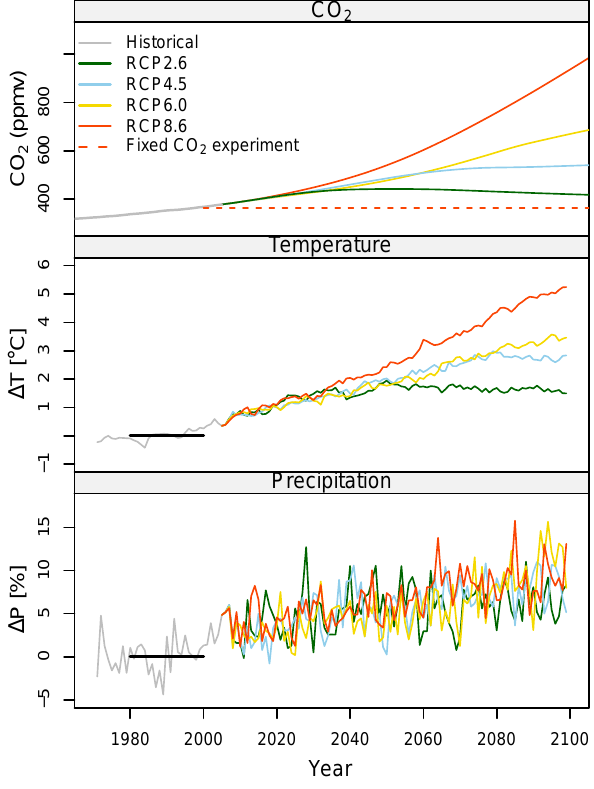
Fig. 1. Climate variables for CO 2 (RCPs), and global mean annual temperature and global annual precipitation anomalies in HadGEM.